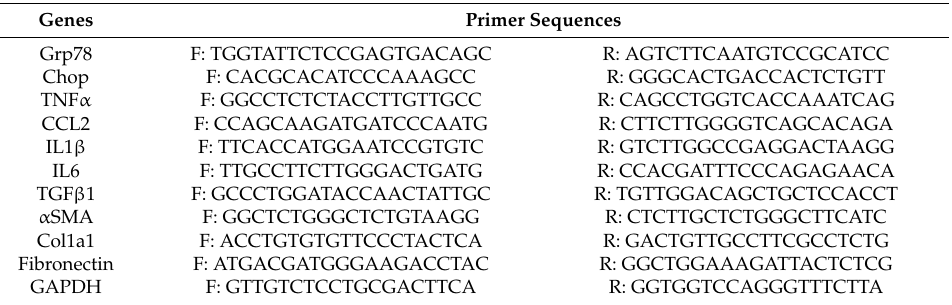
Table 1. List of mouse primer used for real-time reverse transcription-polymerase chain reaction (RT-PCR).